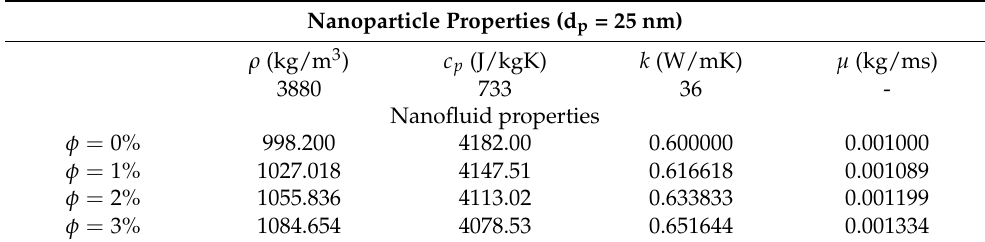
Table 1. Water-Al 2 O 3 nanofluid thermo-physical